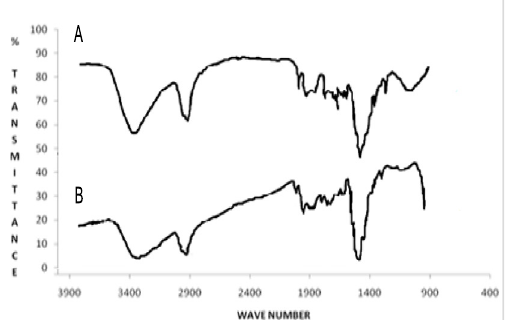
Fig. 3. FTIR spectrum of : (a) CS/PEO without vancomycin (b)CS/PEO with